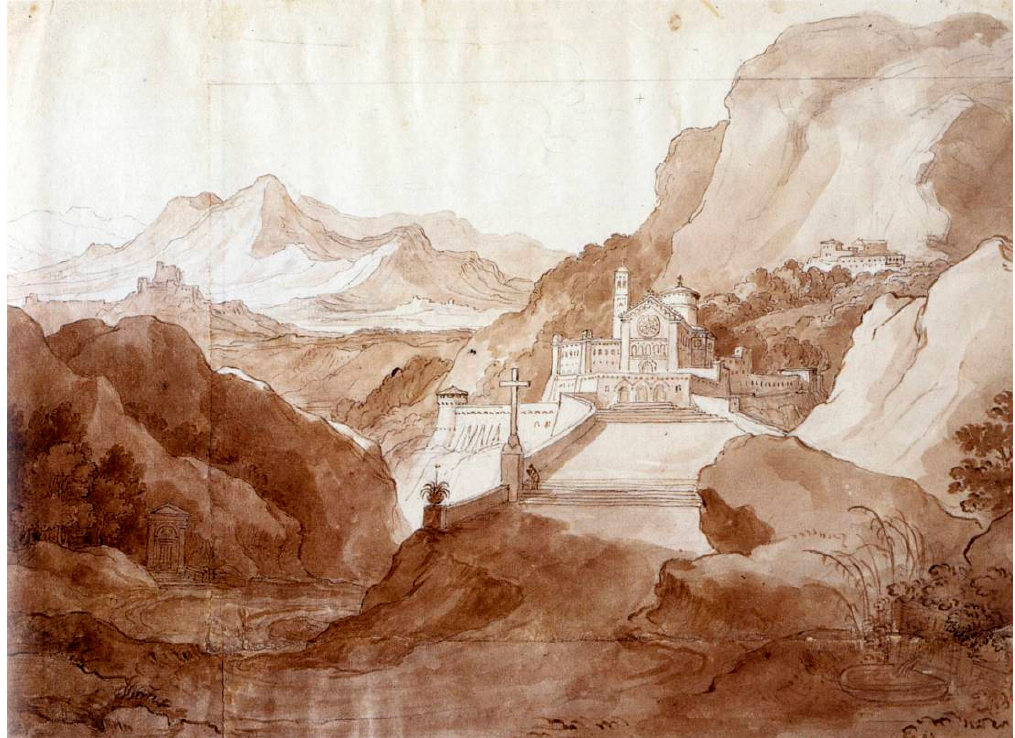
Figure 2. Tommaso Minardi, Paesaggio con complesso monastico ispirato al San Francesco in Assisi , 1810– 1830 abt, Rome, Galleria Nazionale d’Arte Moderna.